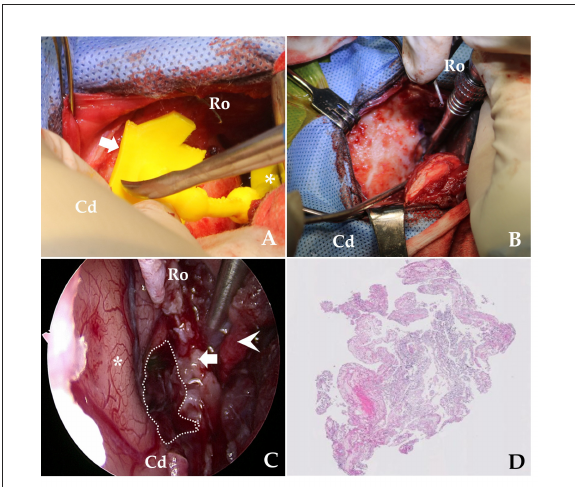
FIGURE3 Overview of the skull-contoured 3D-printed PSP applied to the patient. (A) The pre-operative, skull-contoured attachment arm of the 3D-PSP (white arrow) is mated to the bone, and the pointer (asterisk, *) then indicates the craniectomy site above the tumor. (B) After outlining the drilling site using the pointer, the craniectomy is performed. (C) Intraoperative endoscopy image after removal of the meningioma showing the brain (asterisk, *), bone (white arrow), muscle (arrowhead), and tumor resection site (dotted line). Complete, macroscopic piecemeal resection of the tumor is confirmed by endoscopic imaging. (D) Photomicrograph demonstrating the histopathological criteria for diagnosing a meningioma. On microscopic examination, neoplastic cells are characterized by indistinct cell borders, moderate amounts of eosinophilic cytoplasm, and an oval, centrally placed nucleus with clumped to finely stippled chromatin and a single nucleolus (H&E, X400). Cd, caudal; Ro,